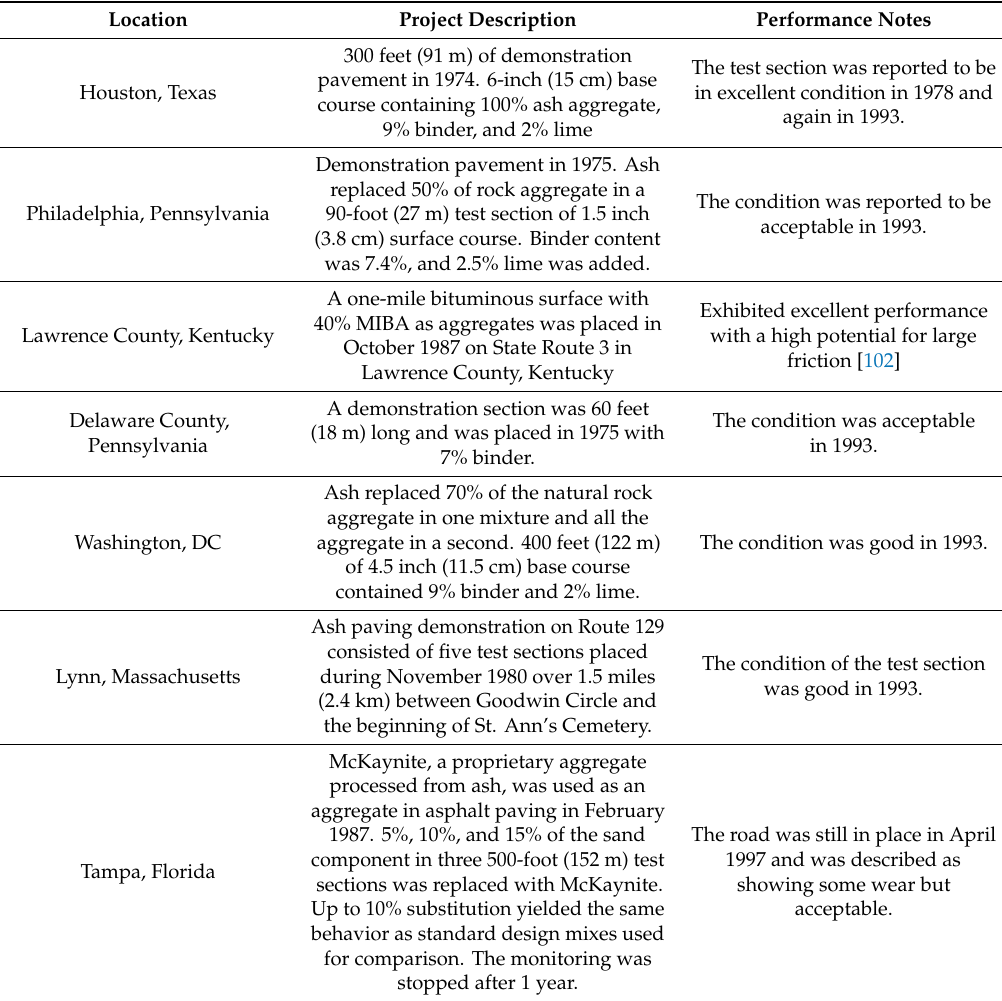
Table 2. Field applications of direct mixing of MSWI ashes in the asphalt mixture and long-term performance evaluation of flexible pavement systems in the U.S.